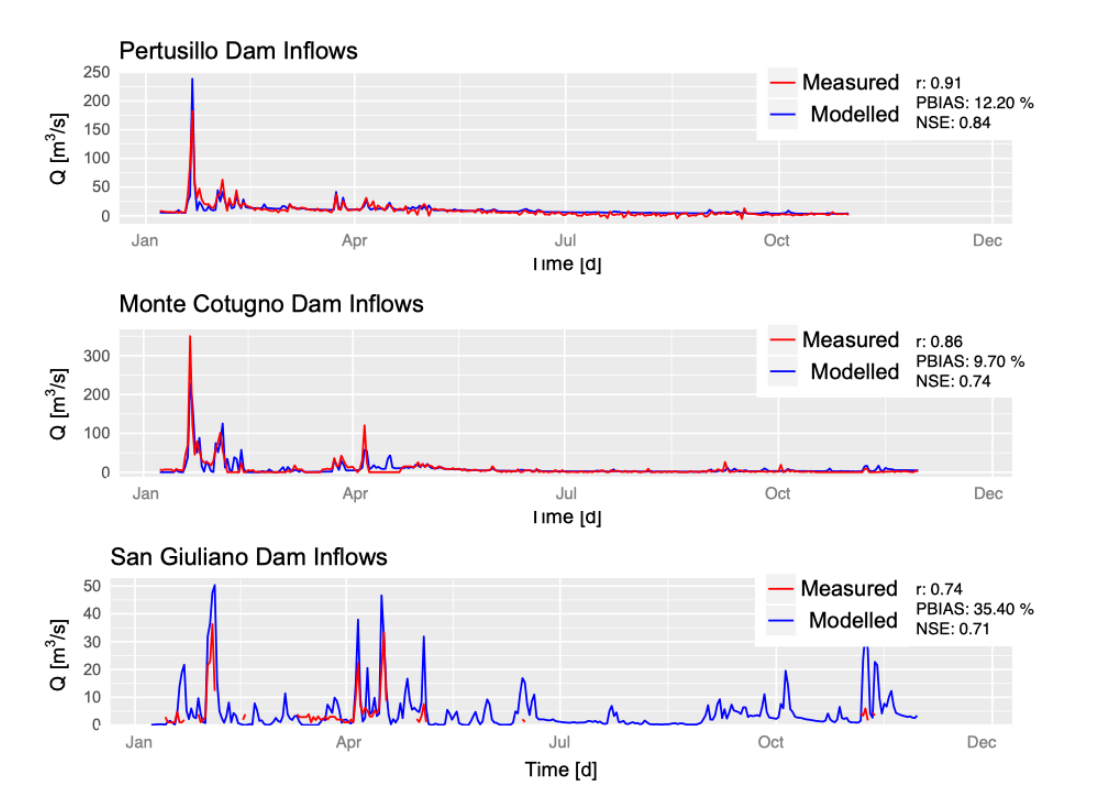
Figure 8. Measured inflows (red line) vs. modeled inflows (blue line) at a daily timescale for the three modeled